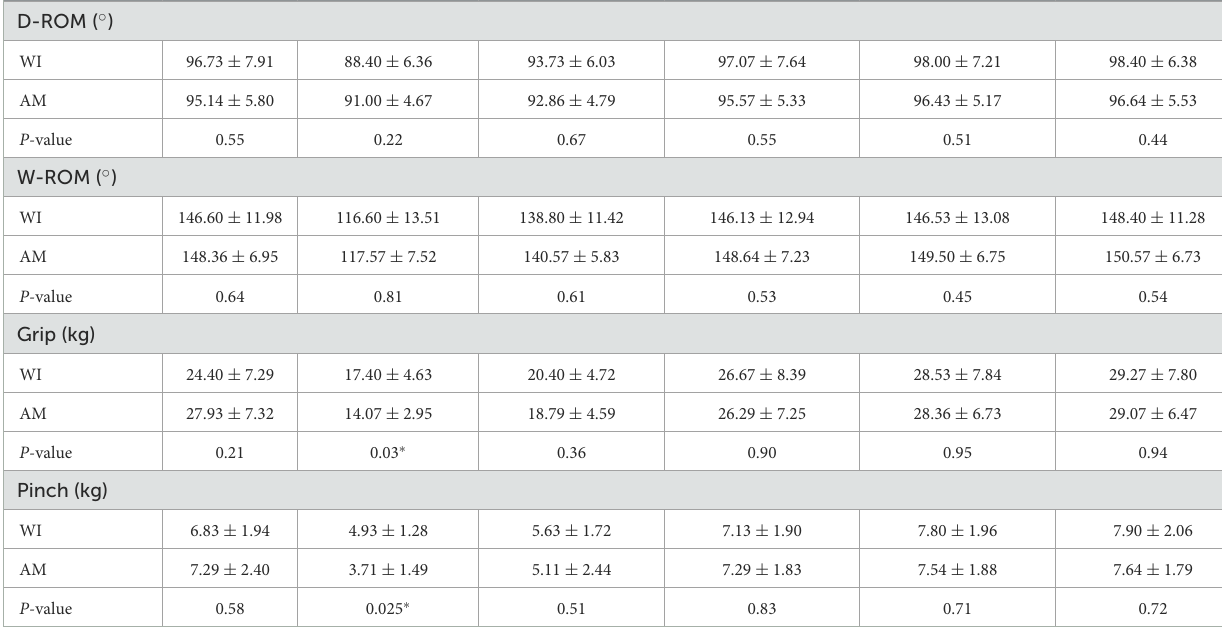
TABLE 2 Outcome measures of strength and